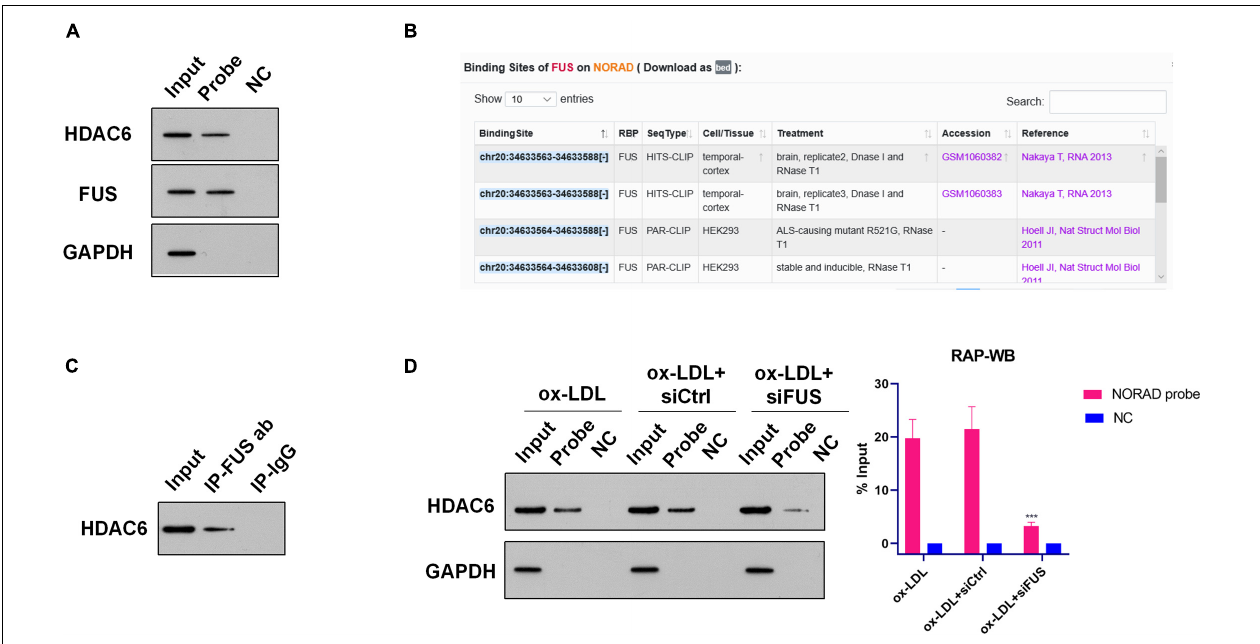
FIGURE 3 | Nucleus lncRNA NORAD associates with HDAC6 via FUS in ox-LDL-treated HUVECs. (A) Representative images of WB following RAP performed by probe-targeting lncRNA NORAD in HUVECs. (B) Potential binding sites for FUS in lncRNA NORAD analyzed by ENCORI. (C) Representative images of Co-IP using an anti-FUS antibody in HUVECs. Rabbit IgG was used as negative control. (D) Representative images of WB following RAP performed by probe-targeting lncRNA NORAD in HUVECs transfected with control shRNA or shRNA-targeting lncRNA NORAD under ox-LDL treatment. In the bar graph, the protein level of HDAC6 was quantified and normalized by input. shRNA; shNORAD, shRNA-targeting lncRNA NORAD; NC, negative control; siCtrl, control siRNA; siFUS, FUS siRNA (*** p < 0.001 vs. other groups). N =